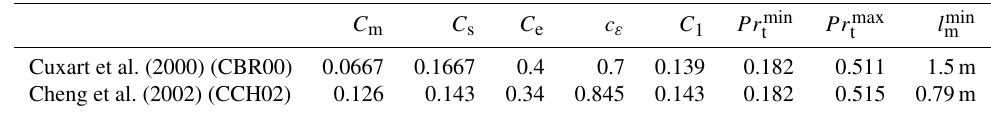
Table 1. Set of turbulence scheme constants from Cuxart et al. (2000) and Cheng et al. (2002). Pr t = C m /(C s φ z ) is the turbulent Prandtl number.